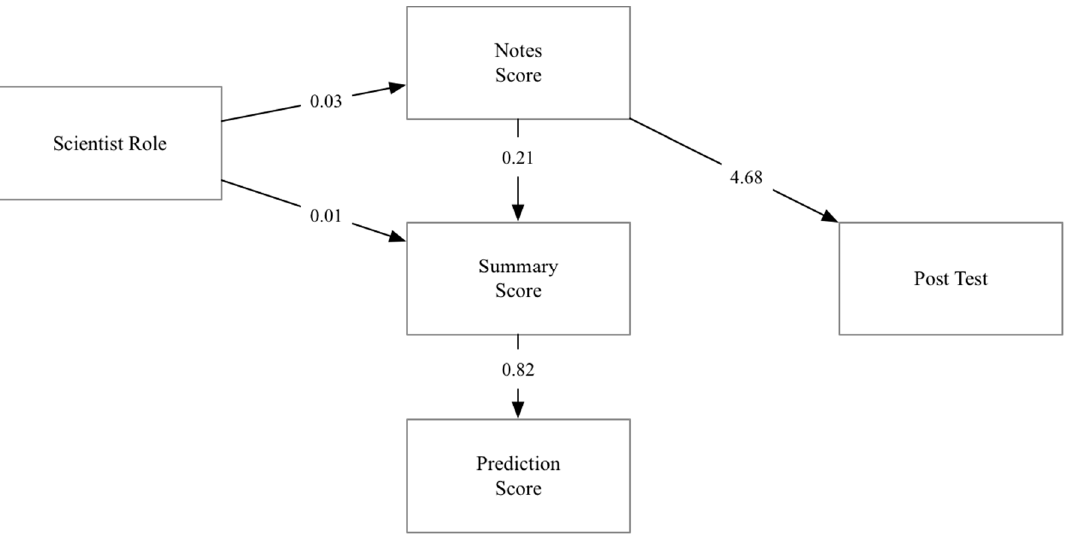
Figure 5. Causal diagram of the direct effect of scientist role on the quality of student notetaking and reading summaries and the subsequent indirect effects on posttest outcomes and quality of justification of student predictions. The relationships between the variables are represented by the unstandardized regression coefficients.